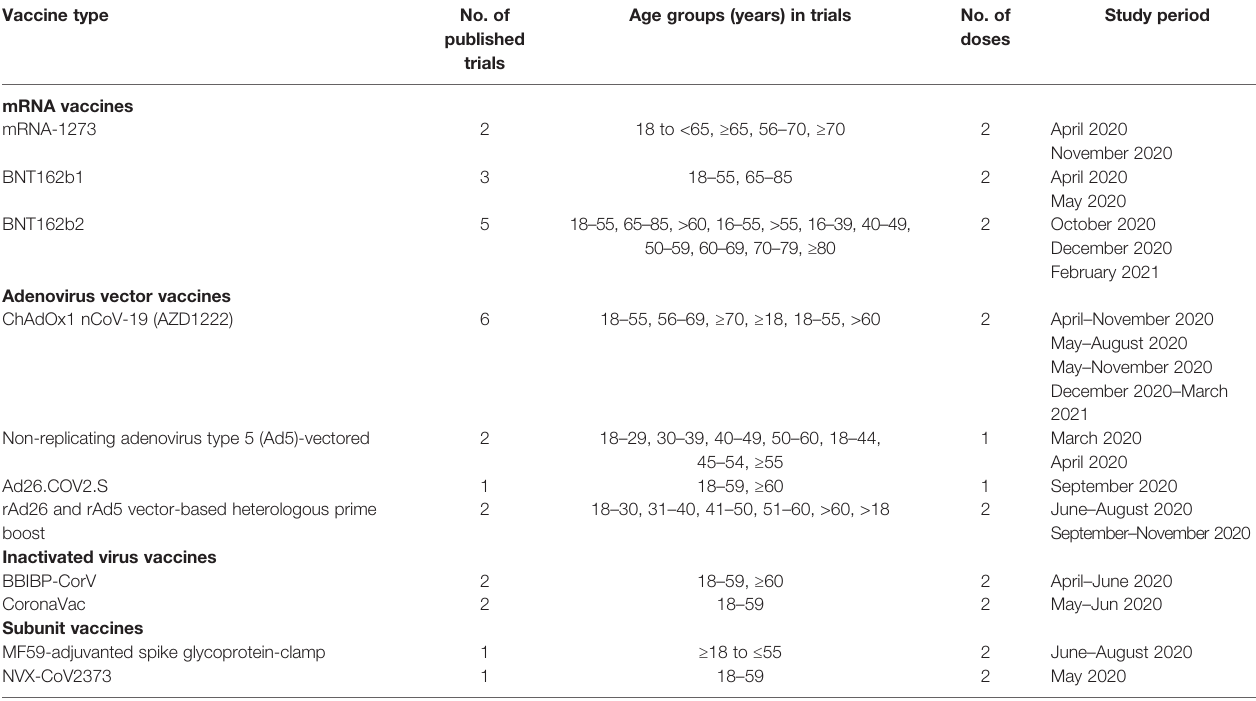
TABLE 1 | Number of trials of phase I/II/III and observational studies published safety, ef fi cacy and immunogenicity of COVID-19 vaccines.